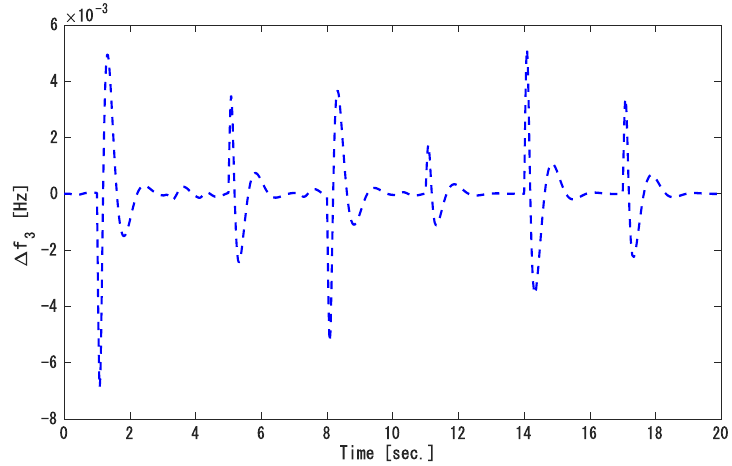
Figure 16. The frequency deviation of 3rd area.